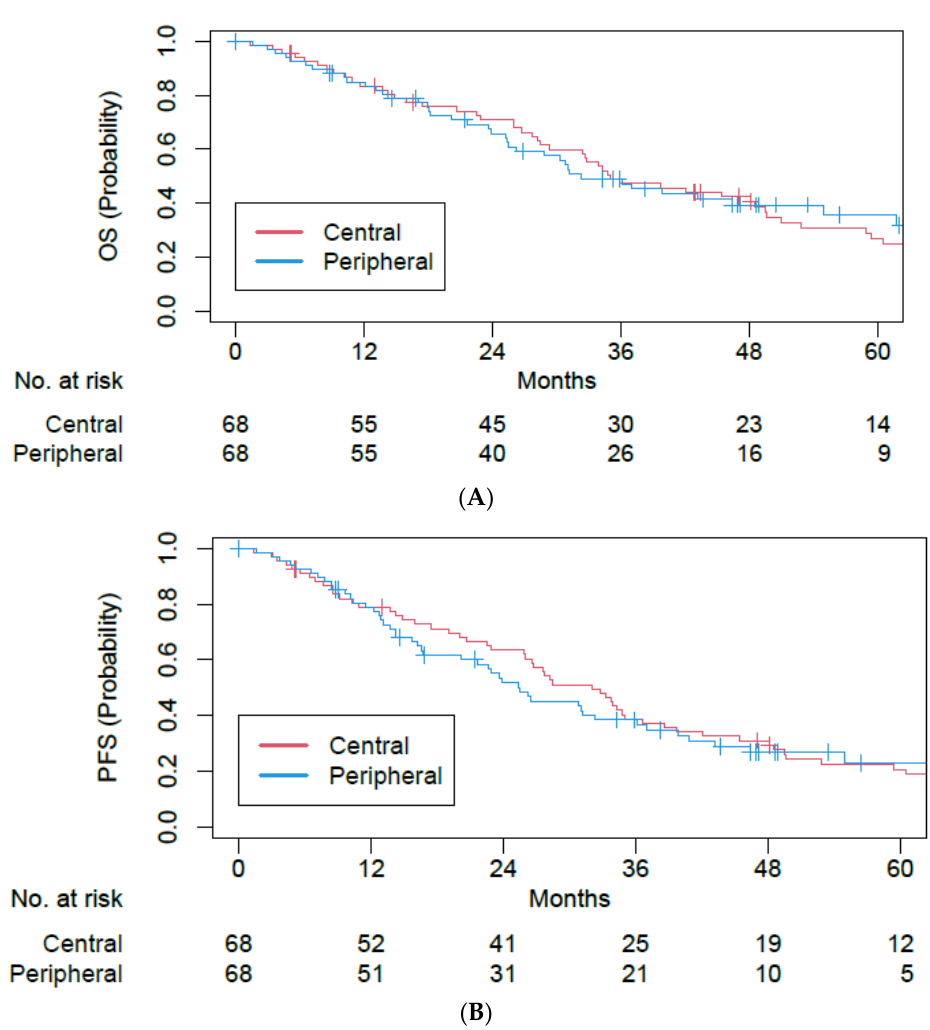
Figure 3. Kaplan–Meier plots for ( A ) overall survival and ( B ) progression-free survival among single- and five-fraction SBRT cohorts after propensity score matching.